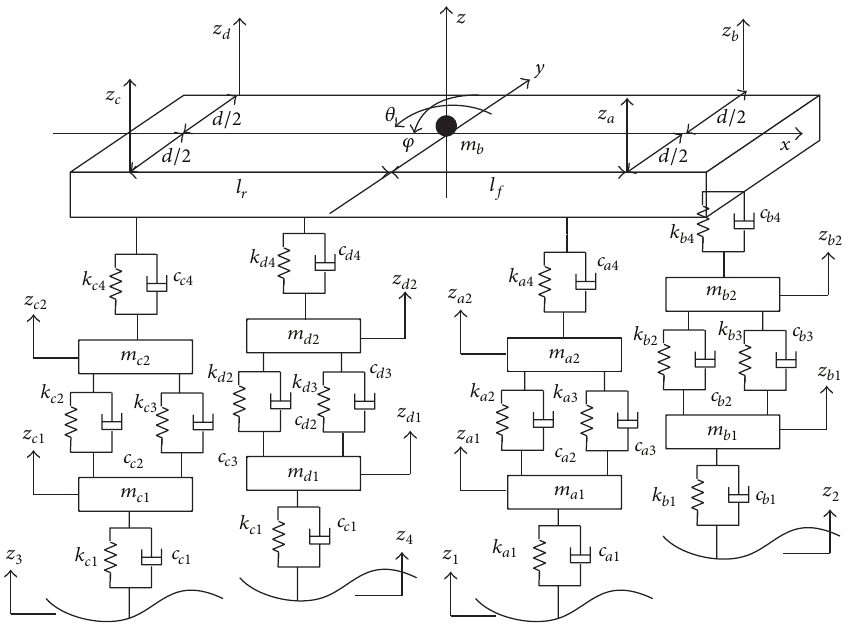
Figure 2: 11-degree-of-freedom physical